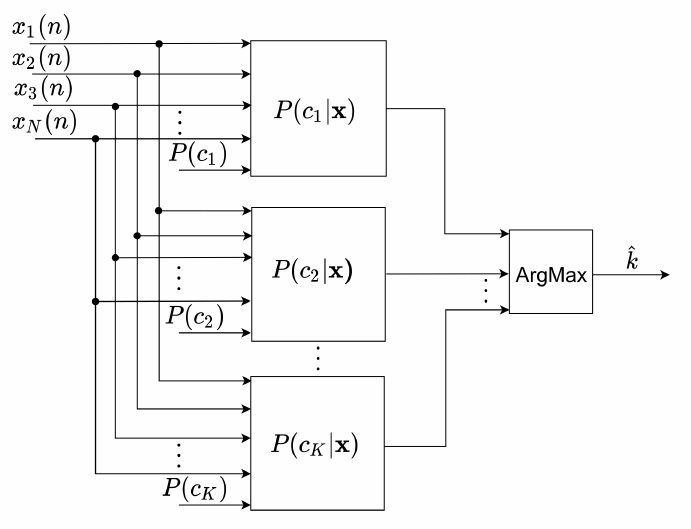
Figure 6. General architecture of the